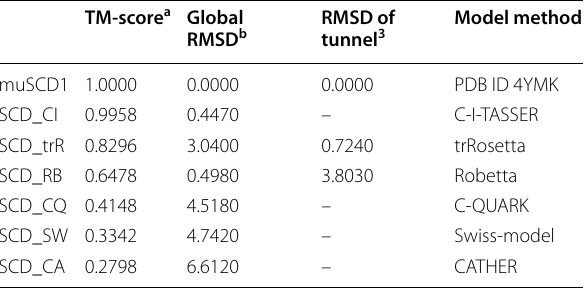
a TM Score is an index used to detect the structural similarity between two proteins. The TM Score is between 0 and 1, where 1 indicates that the two are completely consistent b The global RMSD value measures the degree of difference between the two structures c The RMSD of the residues composed of the substrate tunnel indicated the difference between model and crystal. The amino acid selected here is consistent with Fig.